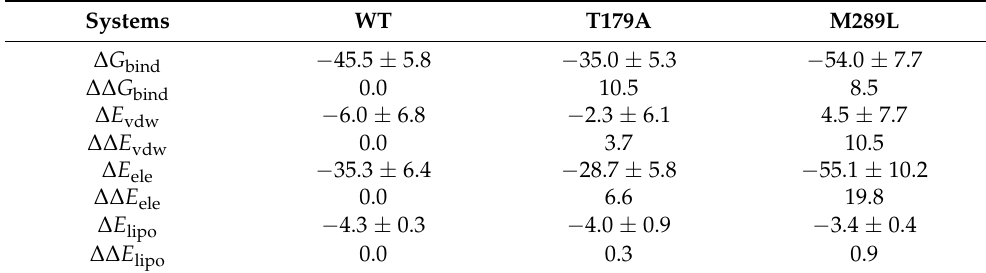
Table 2. The binding energies calculated for the last 50 ns of each